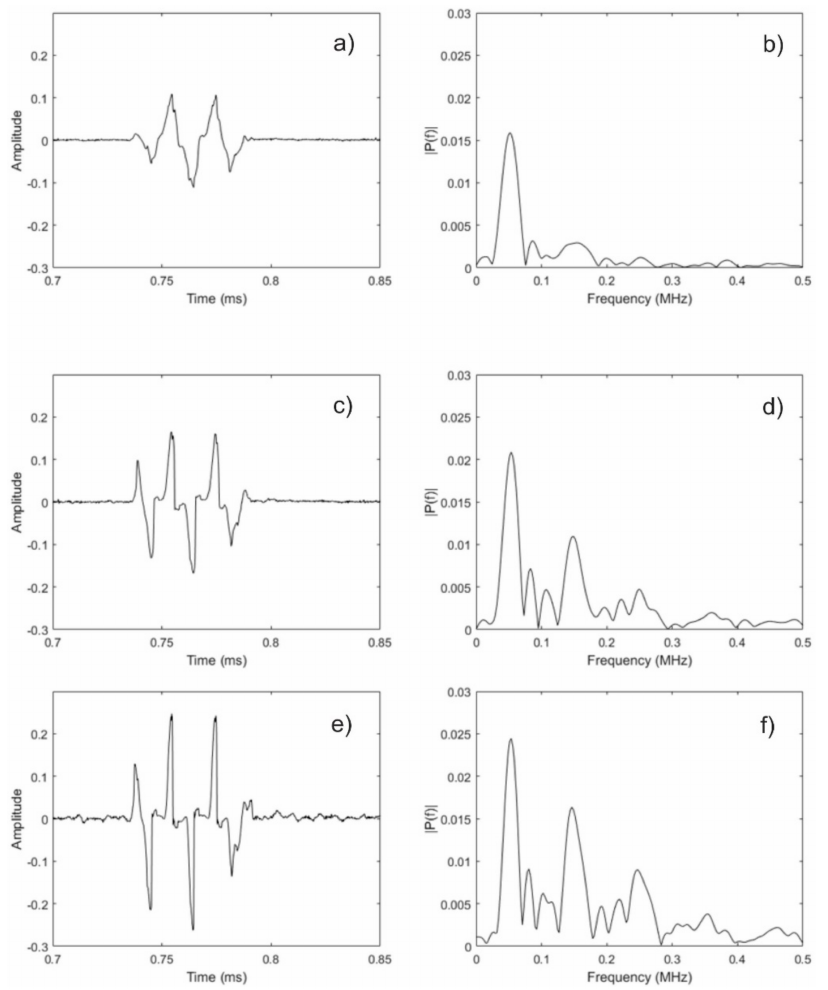
Figure 8. Acquired guided wave reflection signals from the end of the pipe with no magnet liftoff and at different transmitter current settings: ( a , b ) show the normal current level signal and resulting FFT, respectively; ( c , d ) show the doubled current signal and FFT, respectively; ( e , f ) show quadrupled current signal and FFT,